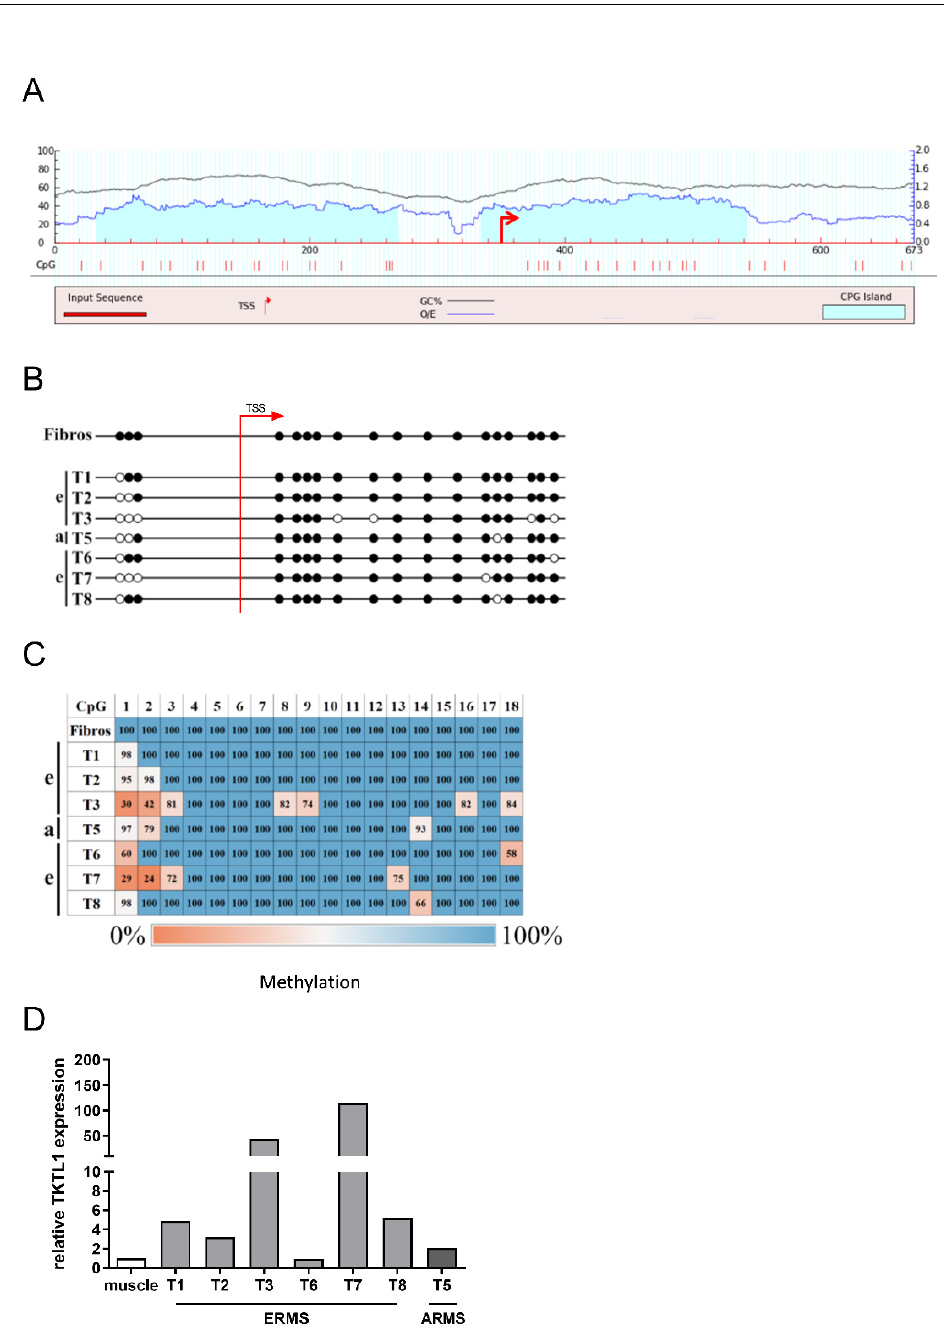
Figure 5. Semi-quantitative methylation analysis of a promoter region of TKTL1 in tumor material from patients with RMS. ( A ) In silico analysis to identify CpG islands in the TKTL1 promoter. Using the browser software MethPrimer, two CpG islands were found in the promoter of TKTL1. TSS and arrow: transcription initiation site; numbers are the size of the promotor in bp. ( B ) BS sequencing of the TKTL1 promoter region in RMS tissue samples. ( C ) Heatmap of the semi-quantitative methylation analysis of RMS tissue samples. The DNA methylation of each CpG dinucleotide is shown as percentage. ( D ) Relative expression of TKTL1 in RMS tissue samples used for quantitative methylation analysis. For the quantification of mRNA levels, a quantitative RT-PCR was performed, with TBP as internal control. The expression levels in the figure are relative values, as the patient samples were compared to respective control tissues. ARMS: alveolar rhabdomyosarcoma; ERMS: embryonal rhabdomyosarcoma; Tx: number of tumor sample; Fibros: fibroblasts; unfilled white circles: un- methylated CpGs; filled black circles: methylated CpGs. Note: As there was not sufficient tissue material available, three additional tissue samples (T6, T7, T8) were used for this experiment.